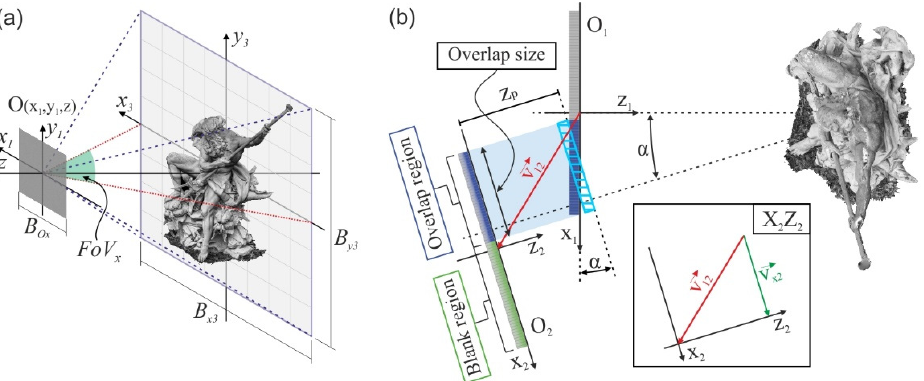
Figure 2. ( a ) Geometry of the wide viewing angle holography; ( b ) scheme of the hologram update method for two consecutive viewpoints.